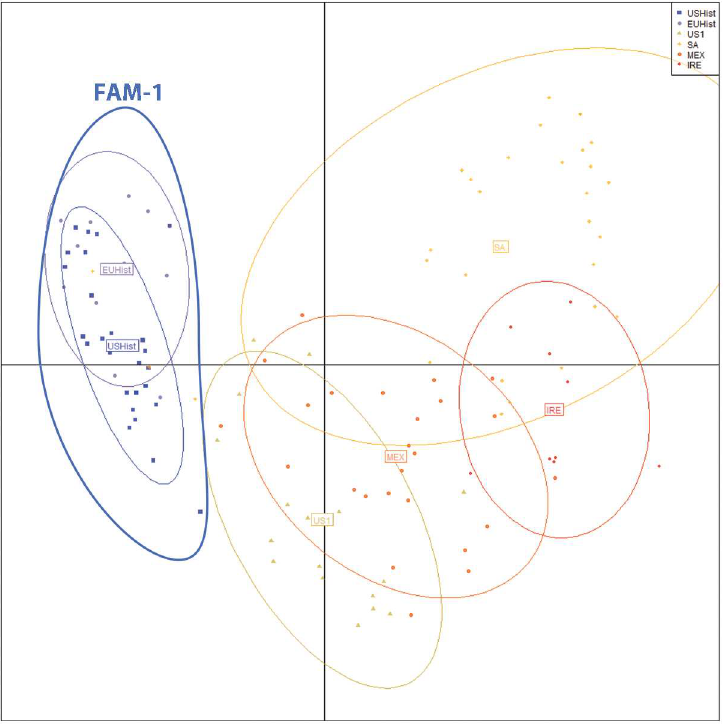
Fig 4. Discriminant Analysis of Principal Components (DAPC) plot of 12-plex SSR loci from modern and historic samples of Phytophthora infestans . Groups are representedby color/symbolas well as by inertia ellipses.Each point represents the SSR genotypeof a single sample. Individuals are groupedby US Historic (USHist 1855–1958); EuropeanHistoric (EUHist 1846–1970); US1: samples identifiedas mtDNA haplotypeIb or clonal lineageUS-1; South American(SA): samples collectedin South America; Mexico (MEX): samplescollected in Mexico; and Ireland (IRE): samplescollected in Ireland.The FAM-1 SSR lineage consisted of US and EU historic